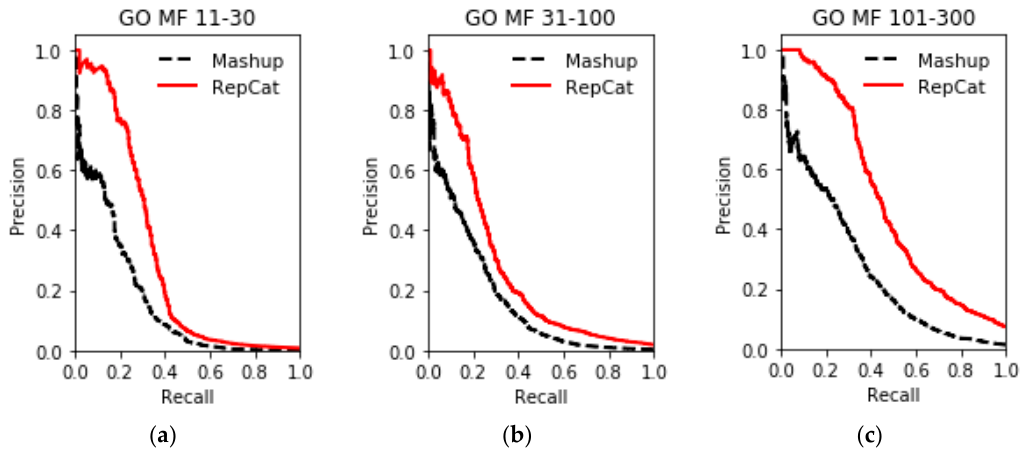
Figure 5. Performance comparison of GO MF function prediction on human datasets between ReprsentConcat and Mashup: ( a ) GO MF 11-30; ( b ) GO MF 31-100; and ( c ) GO MF 101-300.